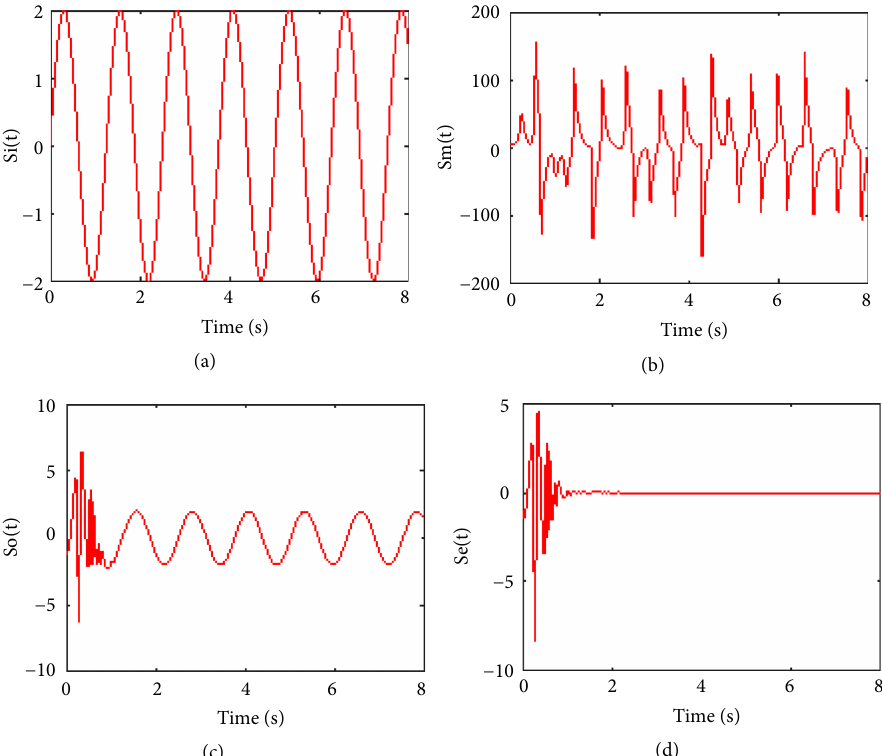
sin (𝑡) = 2 (5𝑡) , (b) the encrypted signal 𝑠 𝑖